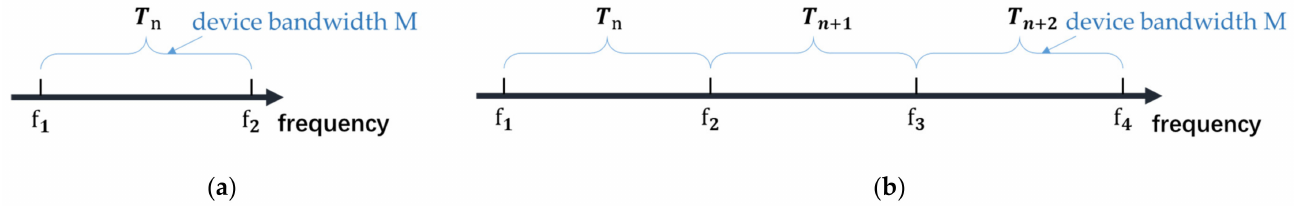
Figure 9. Perception strategy: ( a ) fixed frequency mode; ( b ) frequency hopping